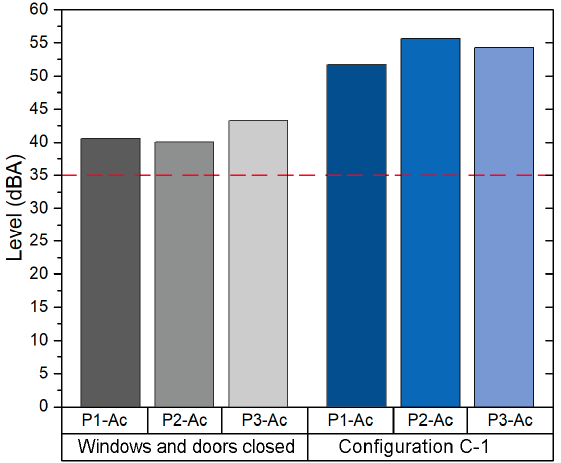
Figure 4. Ventilation rate (ACH) in Classroom B1-A1.